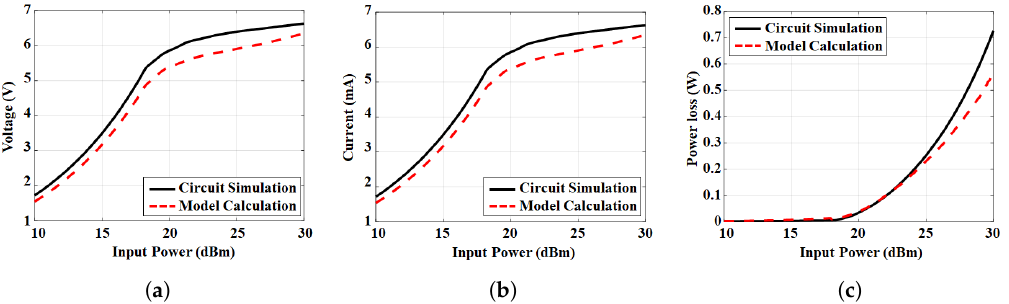
Figure 8. Output voltage, current and diode power consumption according to input power of the proposed model and circuit simulation (N = 1); ( a ) output voltage; ( b ) output current; and ( c ) diode power loss.